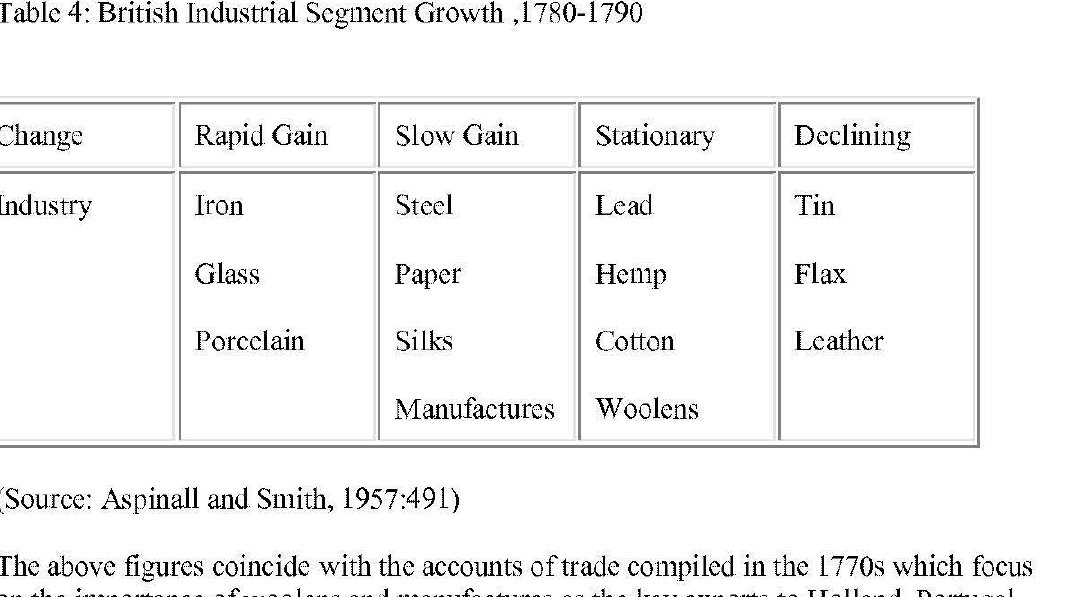
Table 4 : British lndustrial Segment Growth ,1780-1790